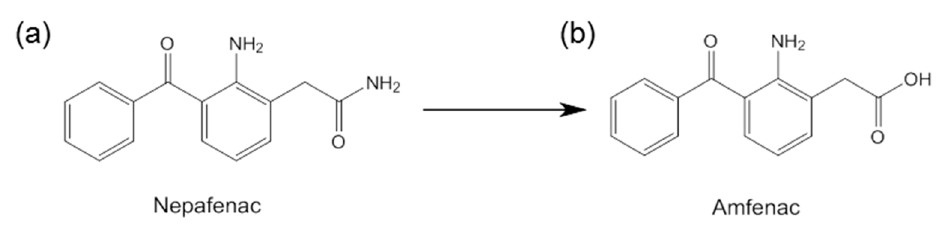
Figure 1. Structures of ( a ) nepafenac and ( b ) amfenac.